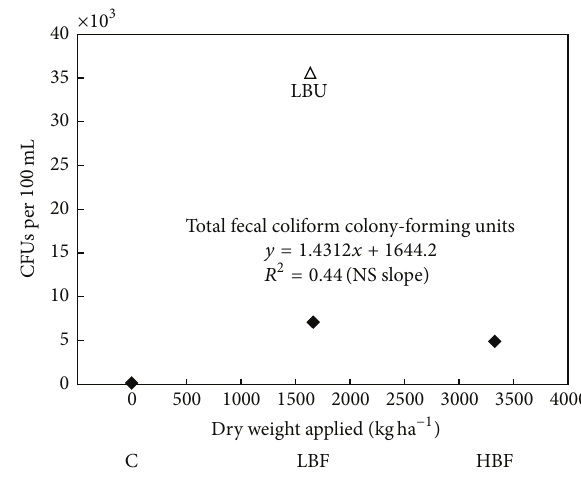
Figure 1: Mean fecal coliform colony-forming units (CFUs) con- centrations in runoff from control (C); low rate of biosolids, filtered by a 1m grass strip (LBF); low rate of biosolids, unfiltered (LBU); and high rate of biosolids, filtered by a 1m grass strip (HBF). CFU level in runoff was not well described by application rate (slope 𝑃 = 0.53 ); however, mean CFU level of the unfiltered treatment was much greater. LBU mean is included for reference.